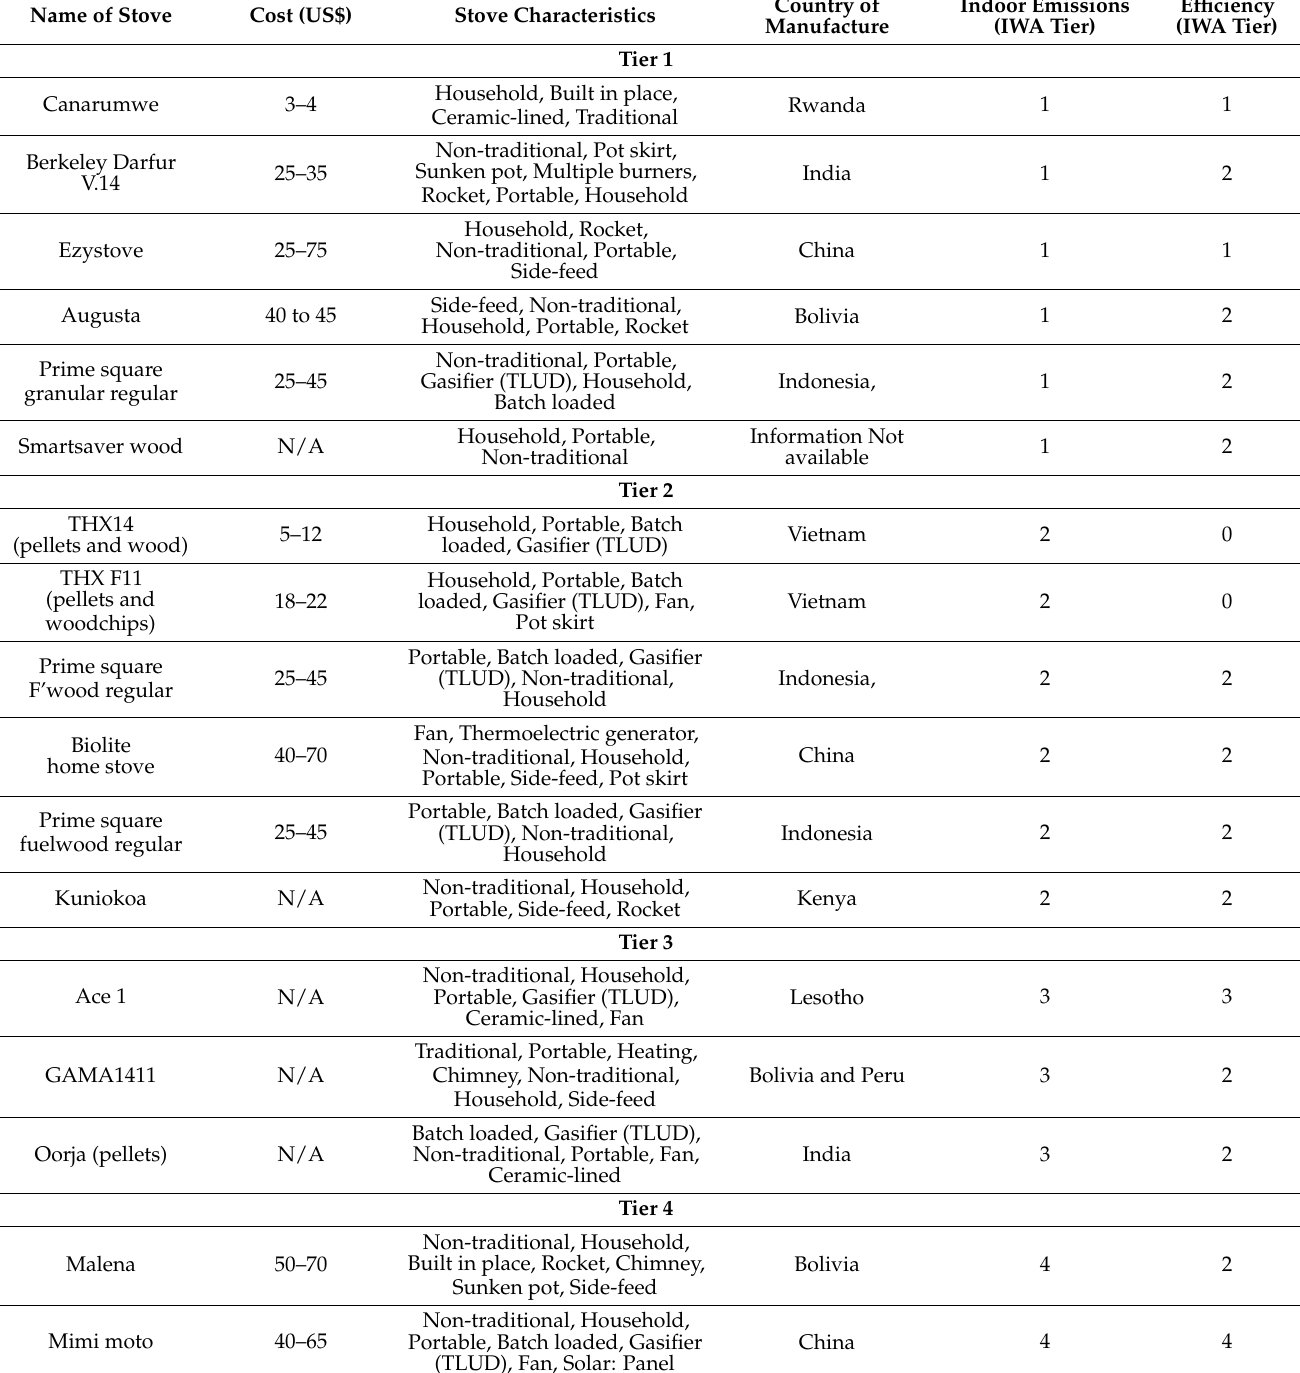
Table 1. Household biomass stoves available on the market (Tier 1 and above for indoor